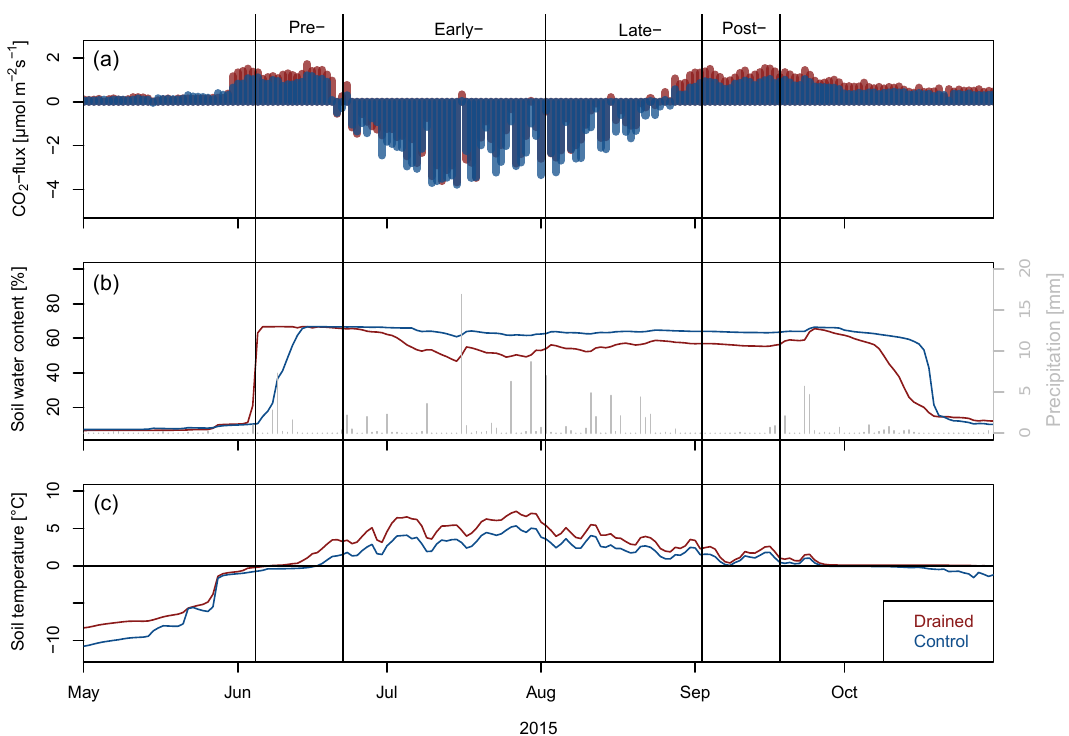
Figure A1. Daily mean (a) carbon fluxes, (b) soil water content at 0.08m depth, and (c) soil temperature at 0.08m depth. Since precipitation patterns are very similar between sites, only data from the drained site are displayed. Vertical lines divide the 2015 growing season into